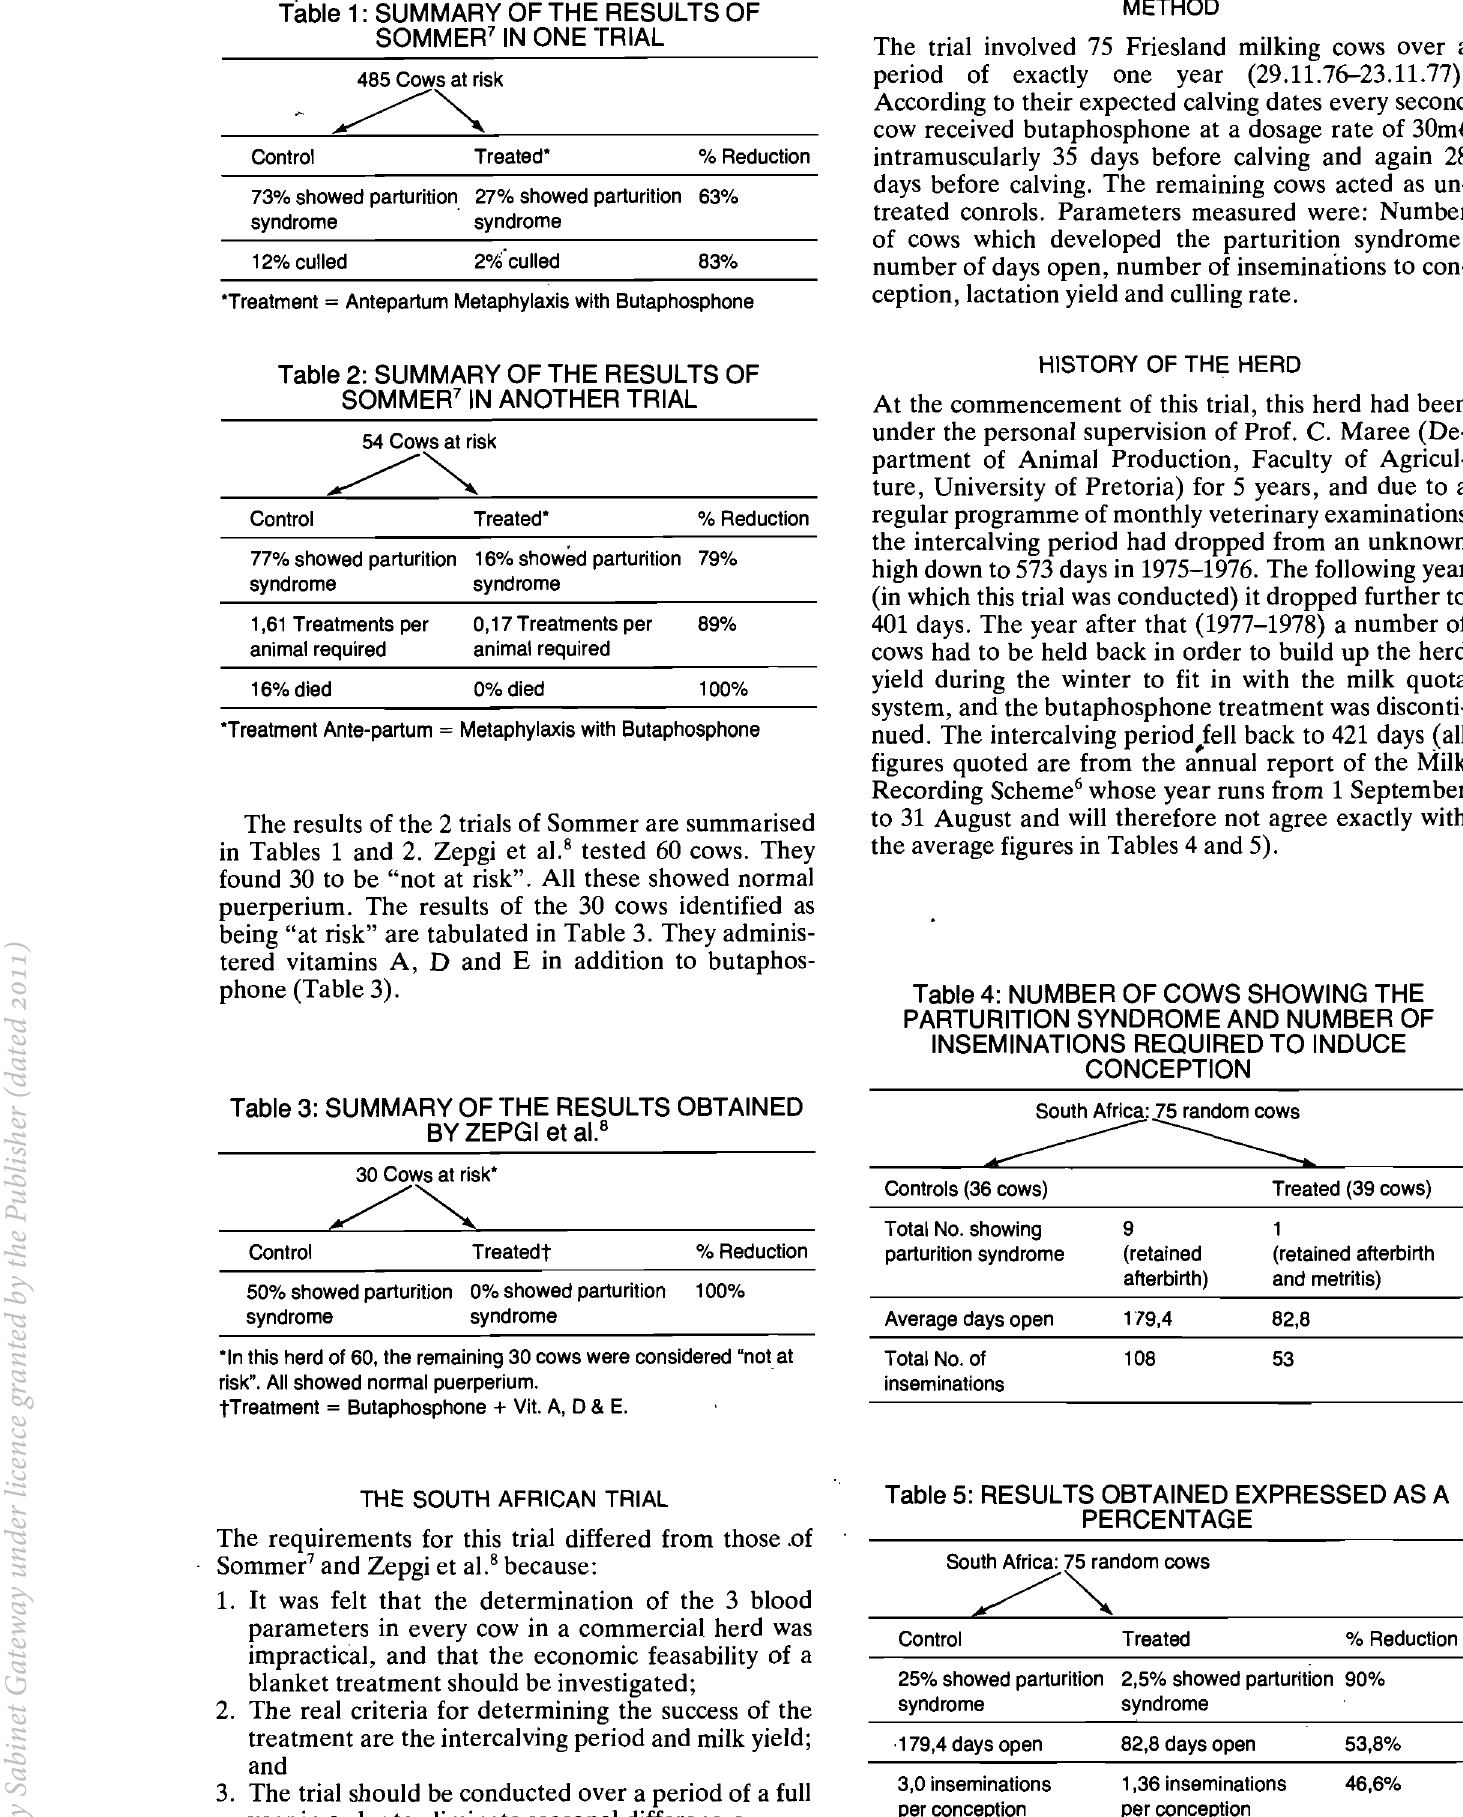
Table 5: RESULTS OBTAINED EXPRESSED AS A PERCENTAGE South Africa: 75 random